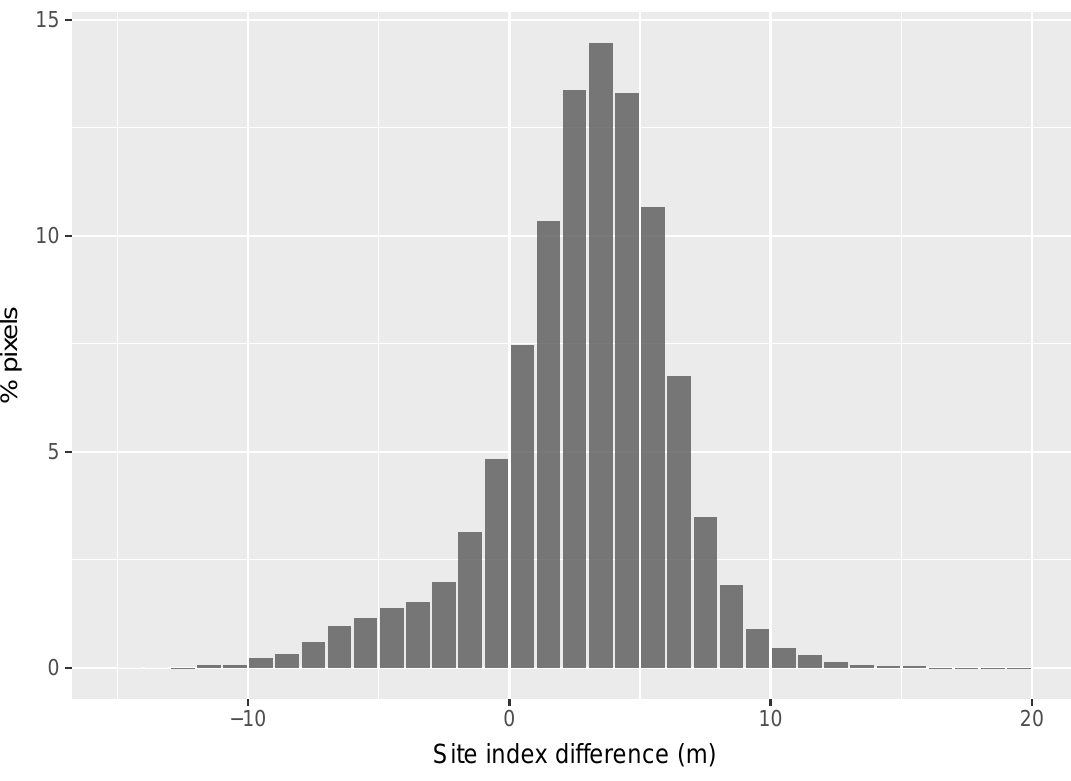
Figure 13. The difference between ALS-predicted site index (as of 2008 and 2010) and SSURGO-estimated site index (around the 1970s). Histogram mean = 2.8 m, median = 3.2